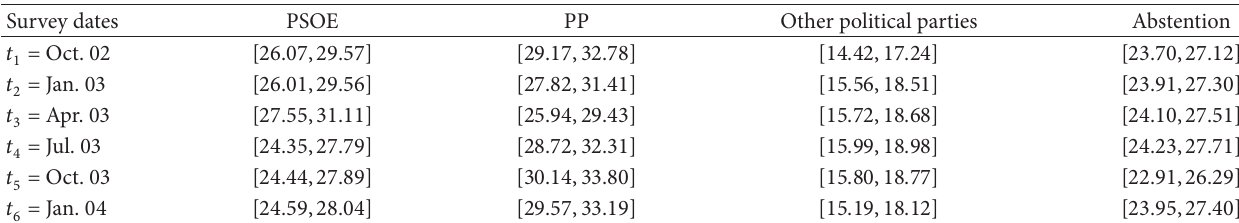
Table 4: 95 % CI of the CIS surveys data using the joint multinomial probability function of each